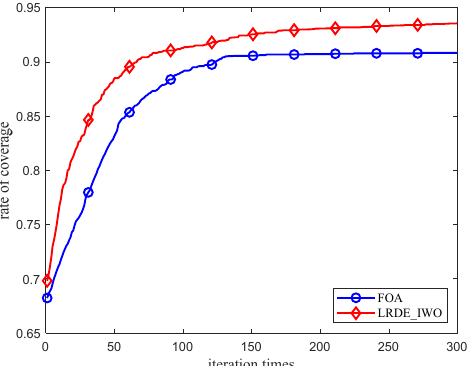
Figure 8. FOA and LRDE_IWO coverage optimization iterative curve.